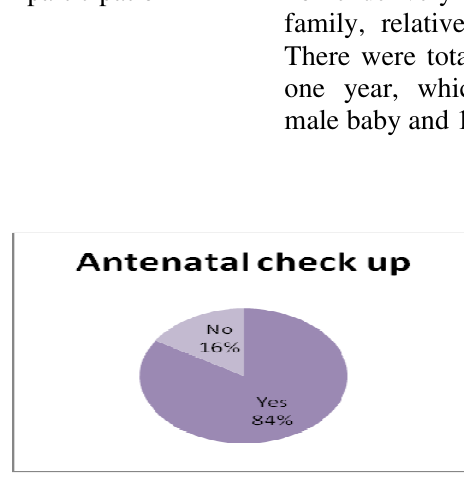
Fig 1: Distrtibution of utilization of Antenatal